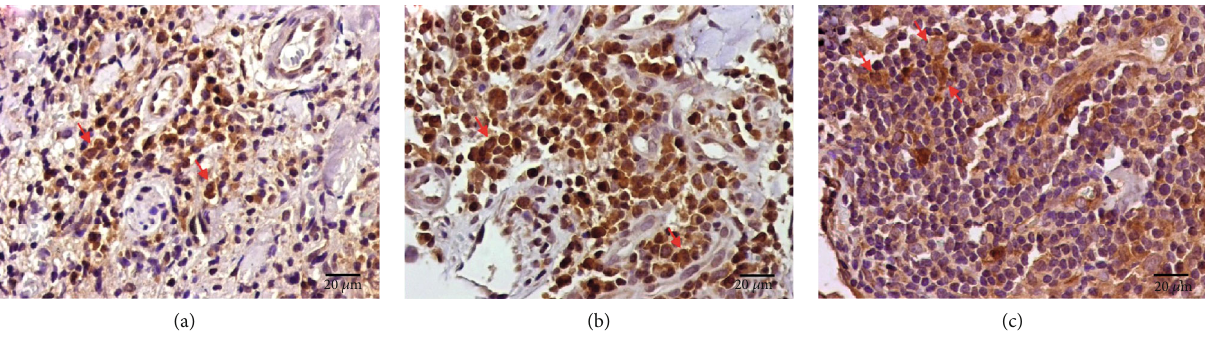
Figure 5: Immunohistochemistry of the skin sections from the patients with LCL showing brown IL-1 β + cells (a), IL-18 + cells (b), and caspase-1 + cells (c). The red arrow indicates positive cells. Table 2: Mean and standard error of the cellular densities (cells/mm 2 ) of the di ff erent markers used to evaluate the in fl ammasome response in the skin lesions of the patients with localized cutaneous leishmaniasis (LCL) caused by L. ( V. ) panamensis and in healthy